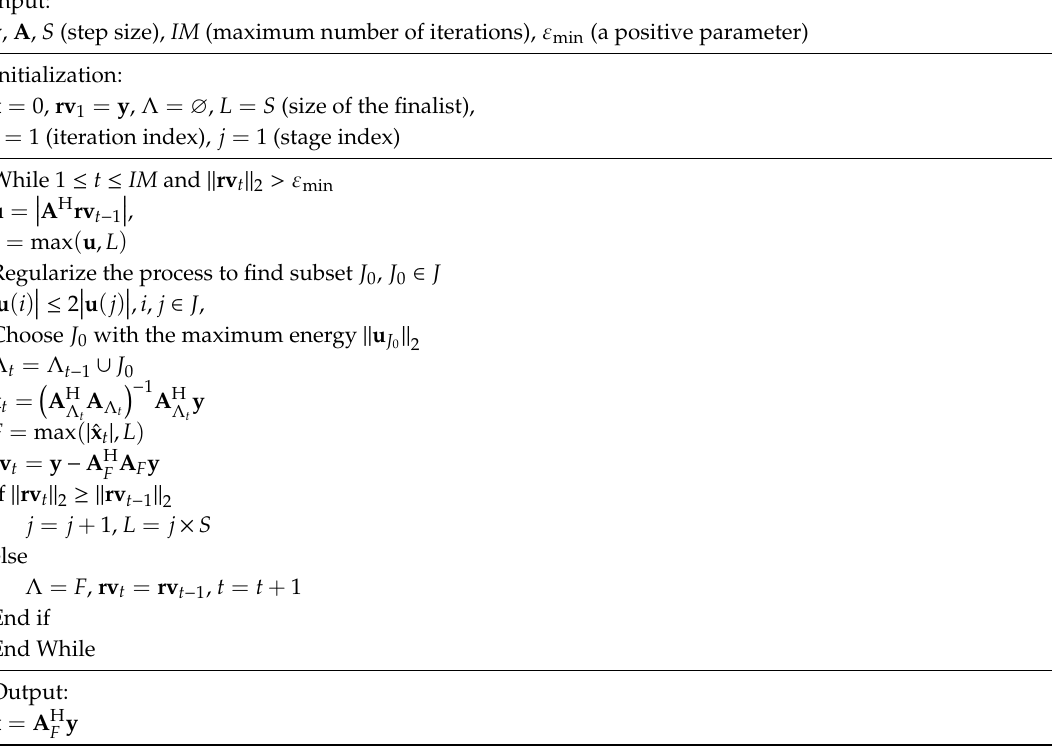
Algorithm 1 Regularized sparsity adaptive matching pursuit (RAMP) algorithm